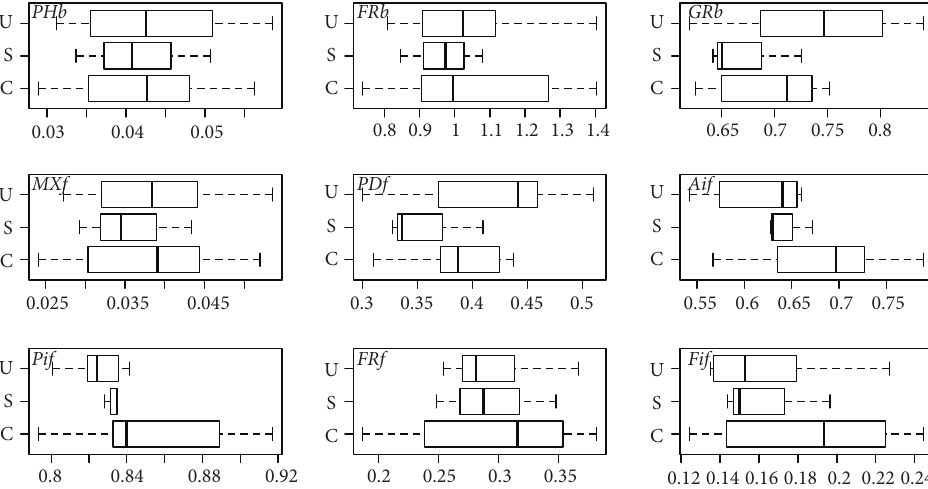
F 6: Leaf means of re�ectance variables by group (canopy C, subcanopy S, and understory